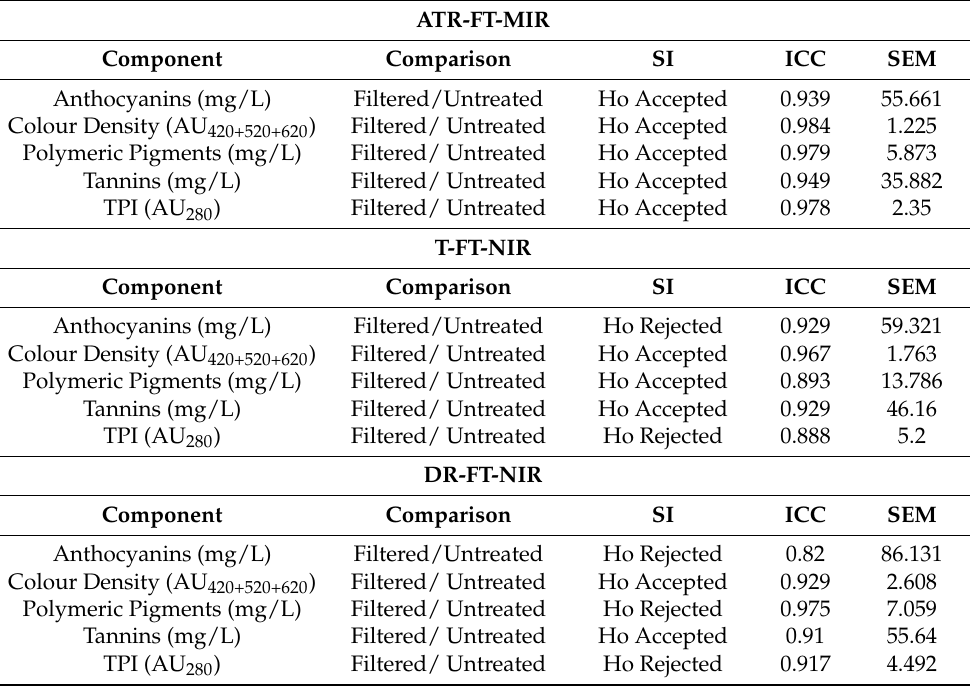
Table 6. Summary Statistics for Sample-Treatment